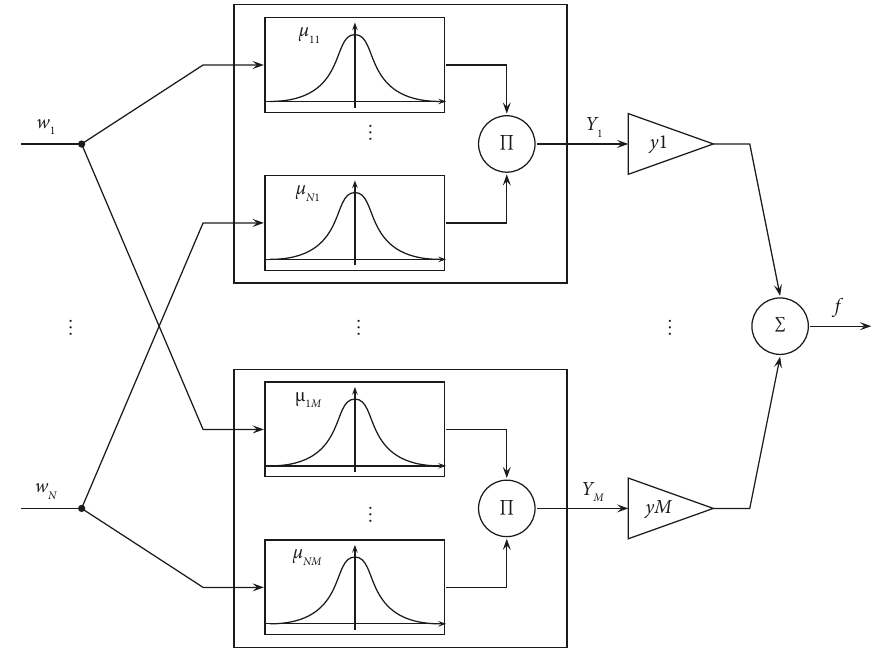
Figure 5: Representation of the neuro-fuzzy